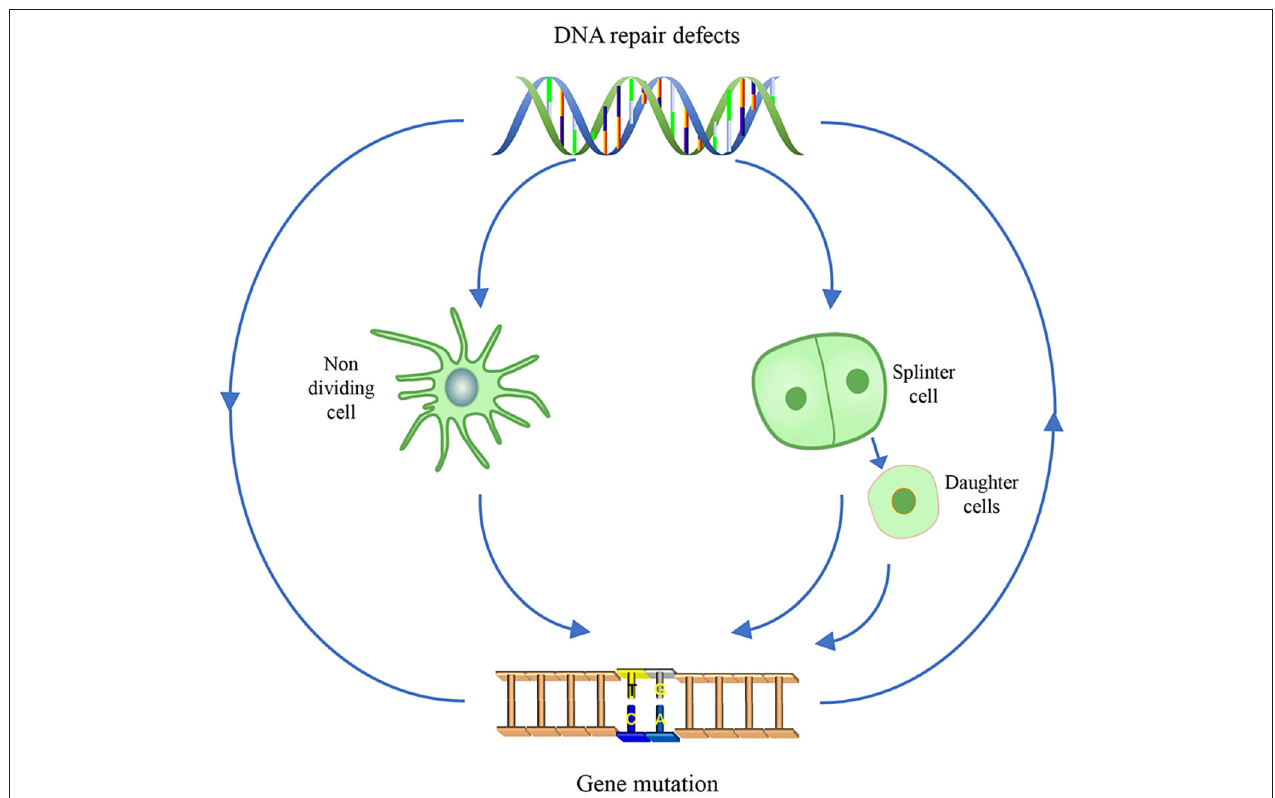
FIGURE 7 | The vicious cycle of gene mutation and impaired DNA repair pathway in TNR diseases. For non-dividing cells, gene mutation disrupting the DNA repair pathway is displayed as cell senescence and apoptosis, that is the outcome of the TNR diseases. For dividing cells, the aberrant DNA repair pathway in turn exacerbates the TNR expansion. In somatic cells, the gene mutation will be passed on and accumulate as the cells proliferate; In germ cells, the aggravated gene mutation is inherited by the offspring, which will exhibit more severe TNA disease symptom in neurons system and aggravated mutagenicity in somatic